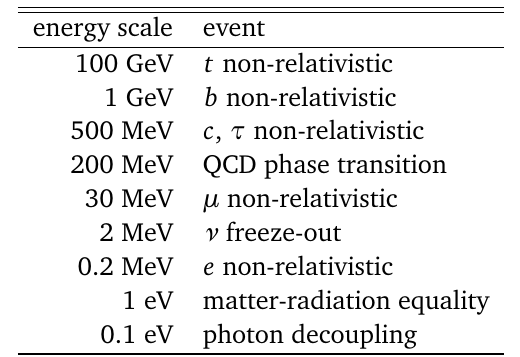
Table 2: An overview over events happening at different energy scales in the early universe. These determine the effective number of degrees of freedom in the Stan- dard Model at a certain energy